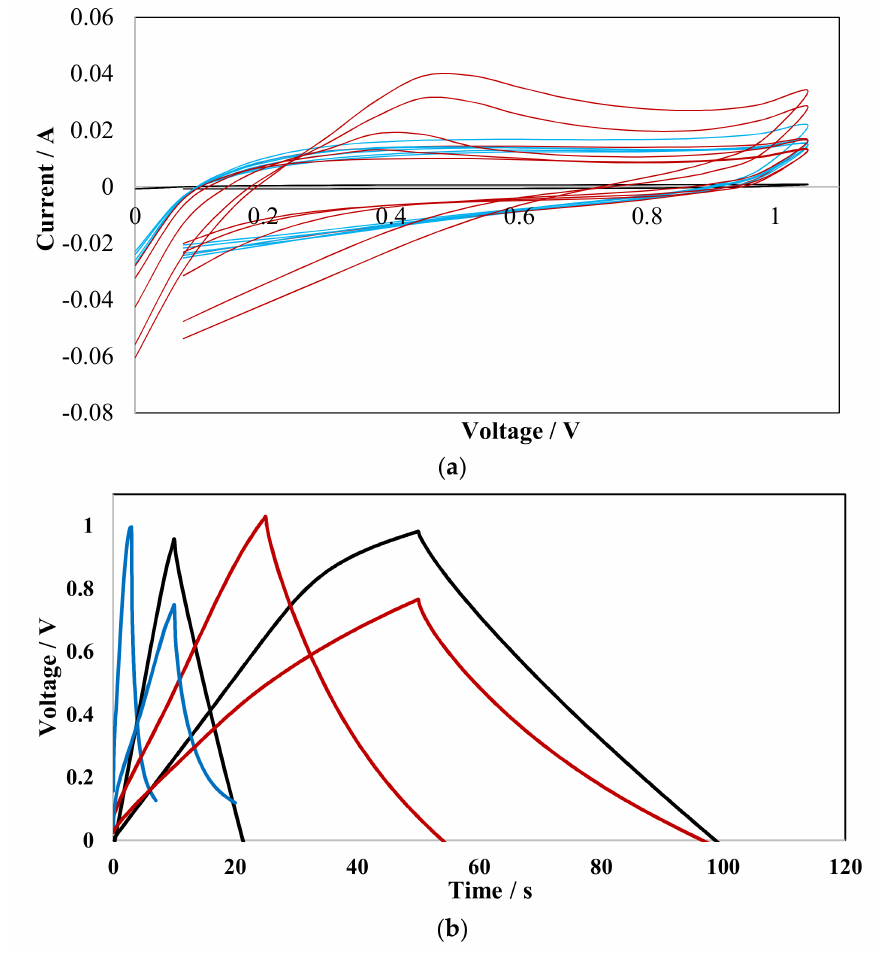
Figure 7. ( a ) CV curves and ( b ) galvanostatic charge discharge curves recorded for CNT (black), CNTOX (red) and Cu-CNT